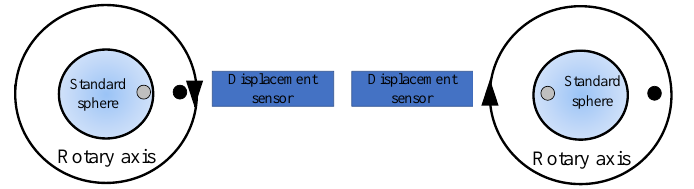
Figure 3. Error separation of inversion method.